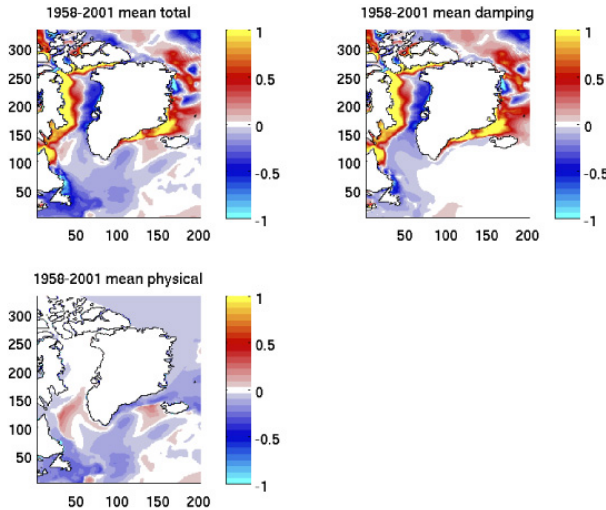
Fig. 3. Total surface water flux (positive upward, units 10 − 4 kgm − 2 s − 1 ) , damping surface water flux, and physical sur- face water flux (precipation plus runoff plus net ice-ocean flux mi- nus runoff), averaged for 1958–2001 in the control